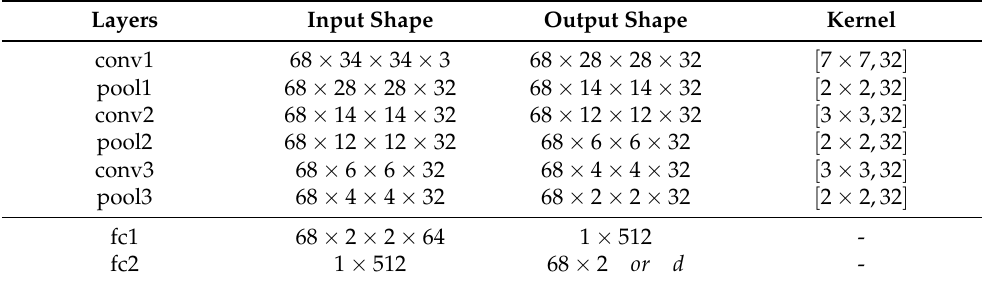
Table 2. Architecture of the dense landmark detection network used in the relation reasoning stage. The value of d changes according to the number of landmarks in the